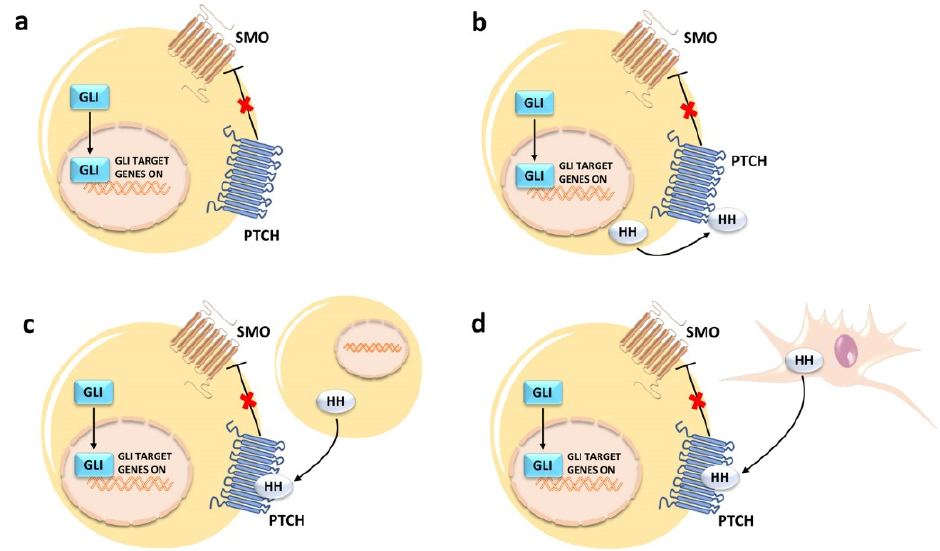
Figure 2. Different modalities of canonical HH signaling activation in cancer cells: ( a ) type I ligand- independent; ( b ) type II ligand-dependent autocrine; ( c ) type IIIa ligand-dependent; ( d ) type IIIb ligand-dependent reverse paracrine. For details, see the text. HH, hedgehog ligand.